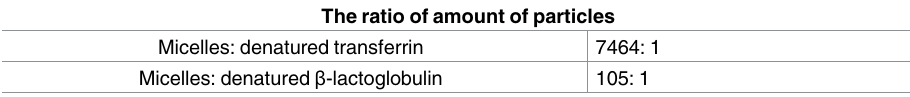
Table 1. The ratio of the number of micelles to the number of proteins.